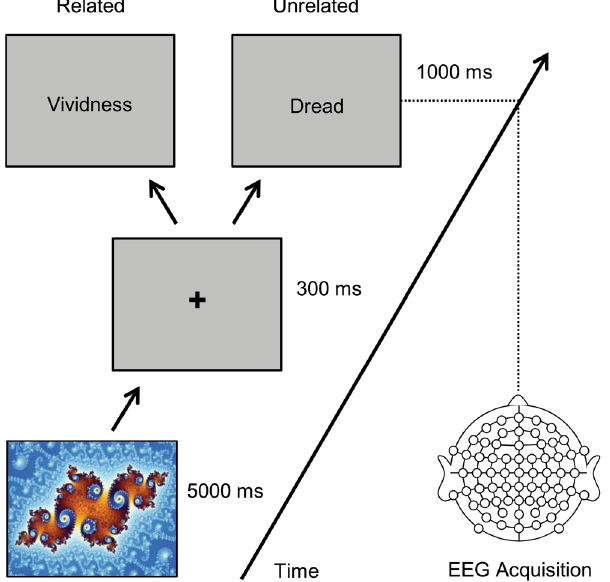
Figure 1. Trial procedure. Abstract images were presented full screen on a 17 ′′ monitor for 5 s. Following a brief interval with a central fixation cross (of 300 ms), a word was presented centrally for a duration of 1 s. Participants were required to make a semantic relatedness judgement while their ERP and behavioral responses were recorded. Displayed as the stimulus is Mandel, zoom 14, satellite julia island by Wolfgang Beyer (https:// commons.wikimedia.org/wiki/File:Mandel_zoom_14_satellite_julia_island.jpg; Wikimedia Commons, CC- BY-SA 3.0;